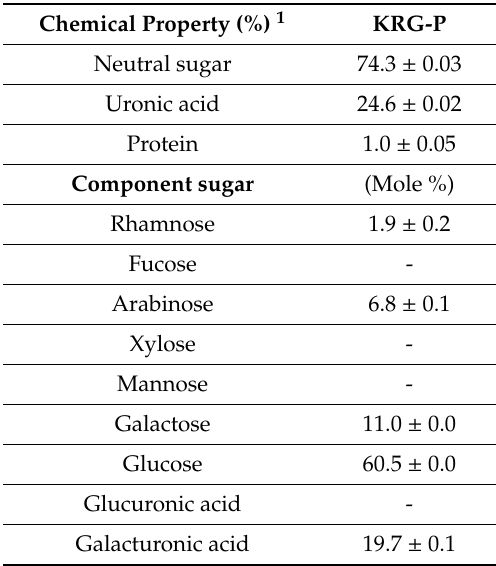
Table 3. Monosaccharide composition of KRG-P isolated from KRG-P.